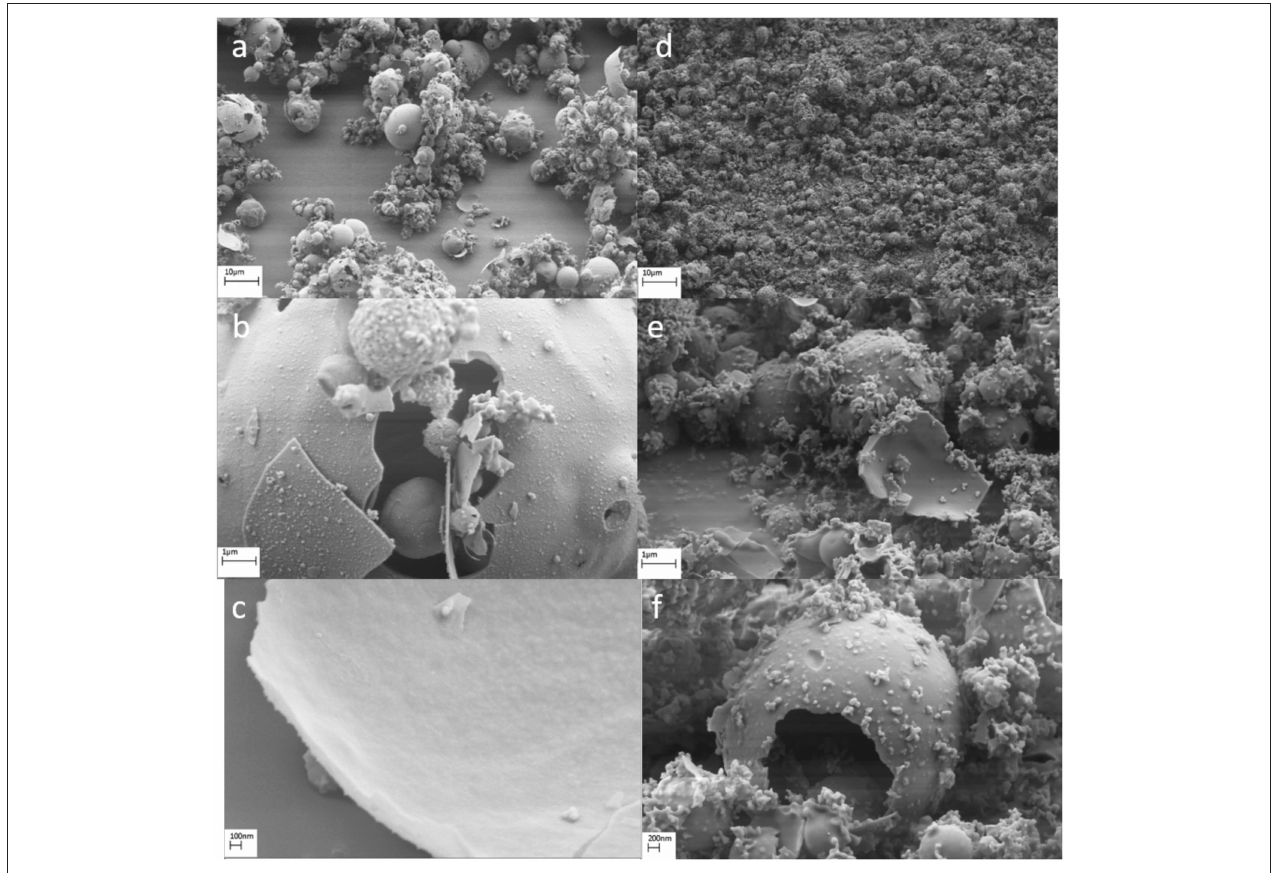
FIGURE 4 | Scanning electron microscopy images for as-synthesized particles from (a–c) sucrose-based solutions and (d–f) DMF-based